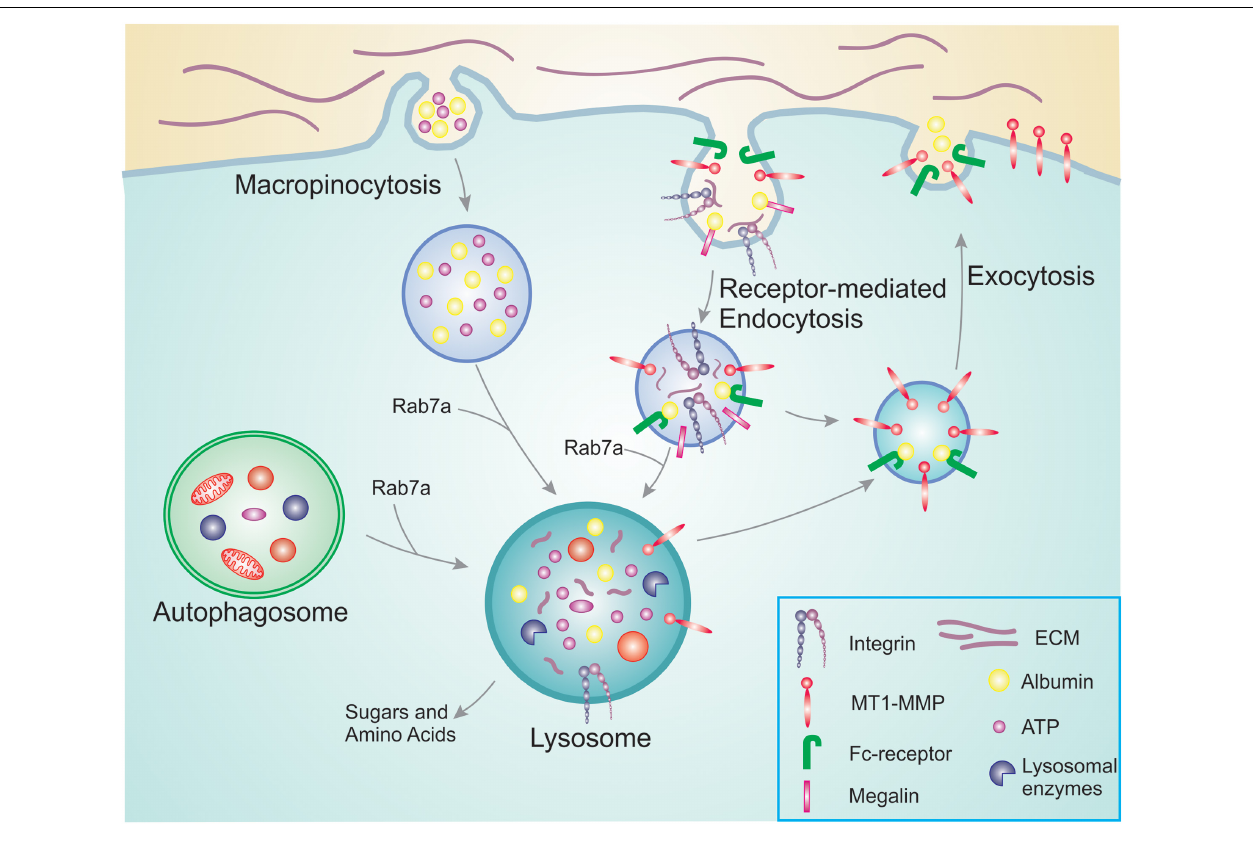
FIGURE 1 | Overview of nutrient scavenging pathways in cancer cells. During cancer progression, cancer cells increase their energy and nutrient requirement to meet the demand of constant proliferation and sustain processes such as migration and invasion. For this, they use membrane trafficking pathways to scavenge nutrients already available. Macropinocytosis allows the bulk internalization of extracellular ATP as well as albumin and other nutrients. In a similar manner, receptor-mediated endocytosis is responsible for the uptake of receptors and their ligands that will be degraded in the lysosomes providing new building blocks to be reused. Examples are integrins that bind to ECM components, and megalin which binds to albumin in the extracellular environment. The internalized albumin can either bind to neonatal Fc receptor inside the endosomes and be recycled back to the plasma membrane, or degraded in the lysosomes. To access the pool of nutrients already available in the cell, cancer cells can hijack autophagy. Engulfed damaged organelles and protein aggregates can thus be broken down and degraded in the lysosomes for reuse. The altered metabolism during cancer progression results in increased MT1-MMP recycling, thus promoting cell